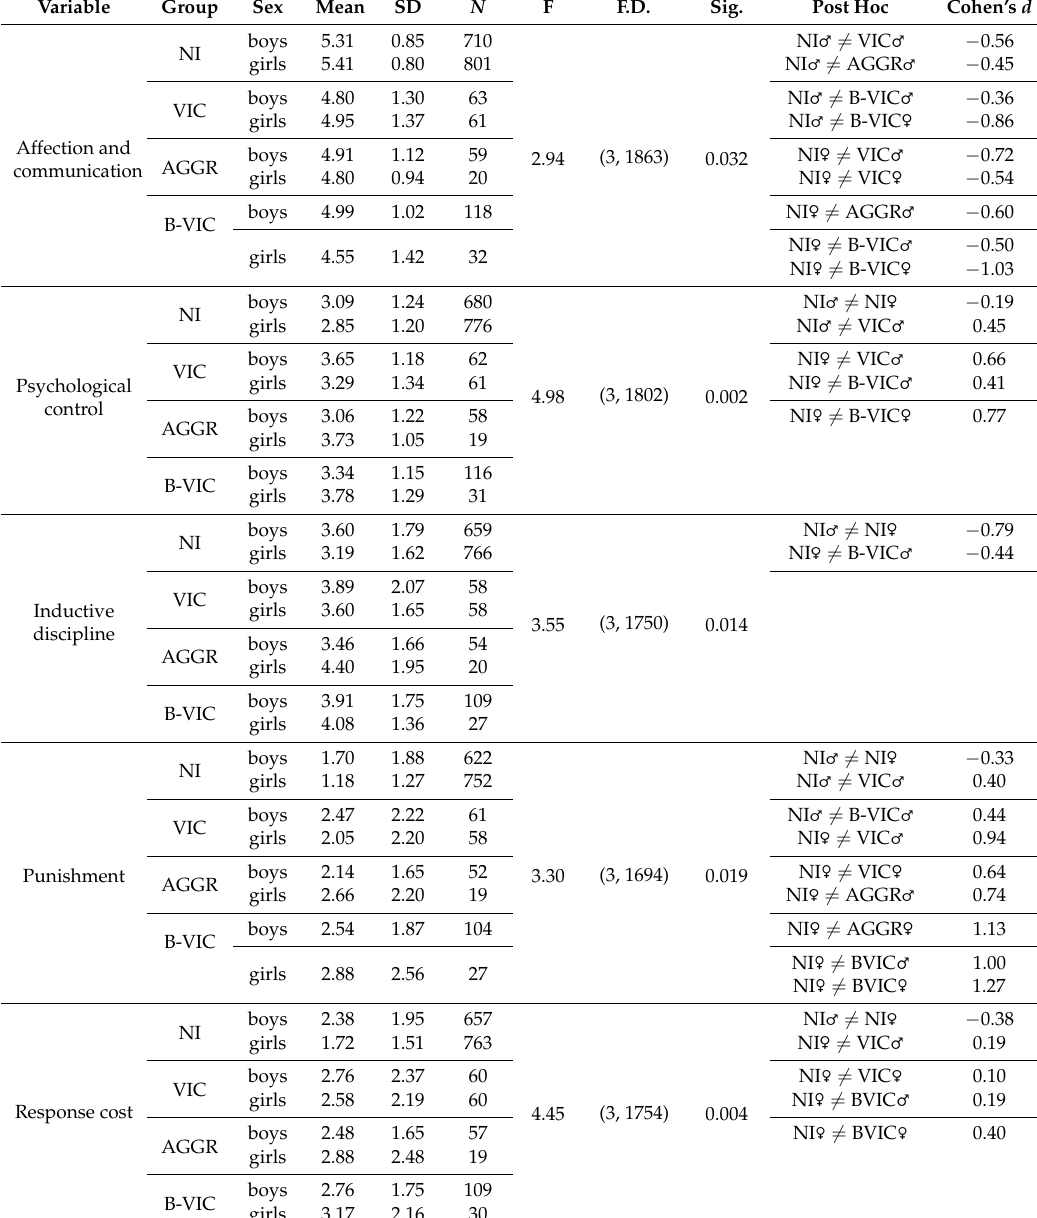
Table 3. Two-way ANOVA about the differences in mother parenting practices according to the interaction between the role of involvement in cyberbullying and gender.